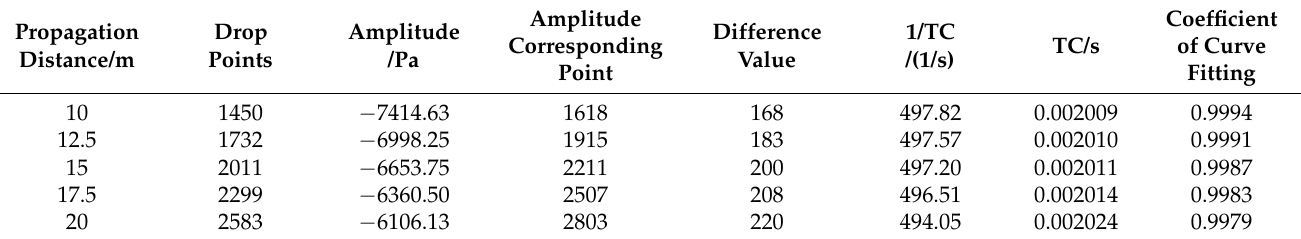
Table 3. Amplitudes and TCs at different monitoring points.